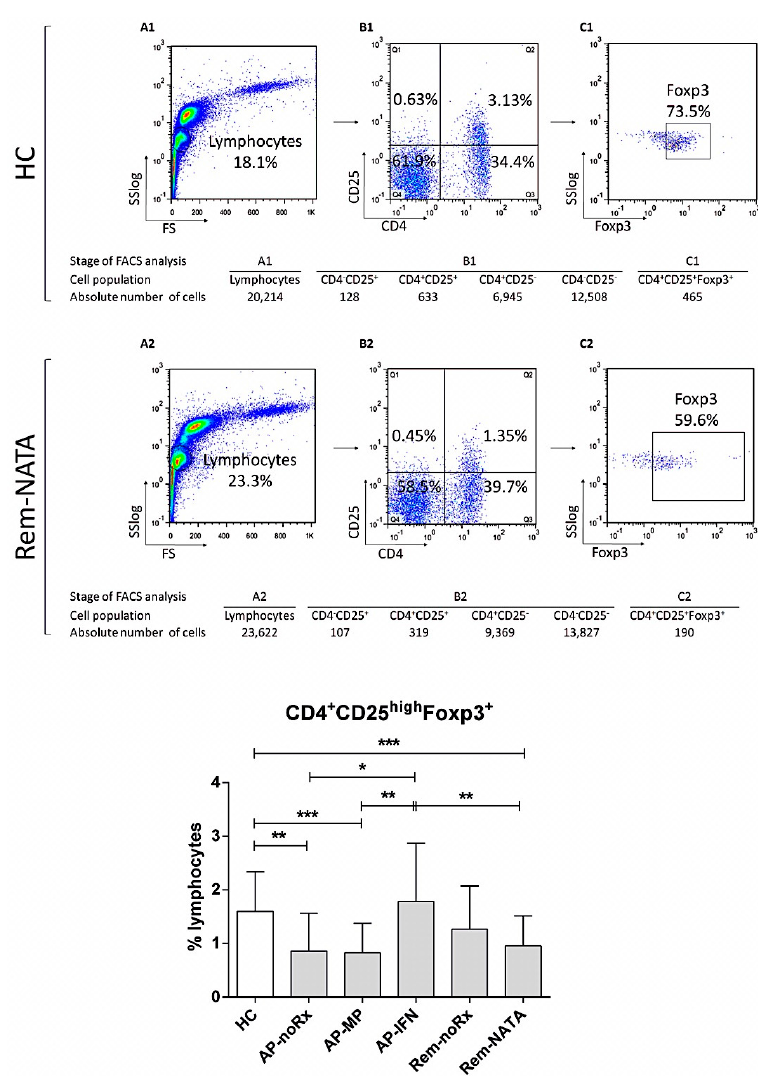
Figure 1. Flow cytometric analysis to determine CD4 + CD25 + Foxp3 + RC levels in human peripheral blood. A representative analysis is shown for one healthy control ( A1 – C1 ) and one relapsing remitting MS (RRMS) patient ( A2 – C2 ). The white blood cells (WBC) were gated on lymphocytes, based